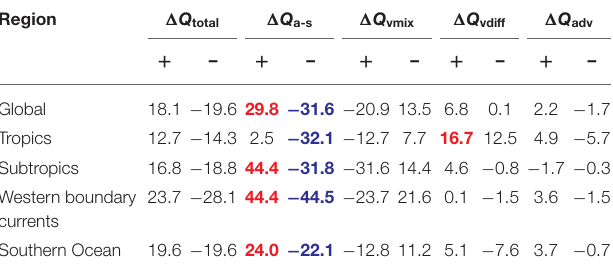
TABLE 1 | Annual mean contributions of the different processes (in Wm − 2 ) to the onset and decline of marine heatwaves averaged over the global ocean, tropics, subtropics, western boundary currents, and Southern